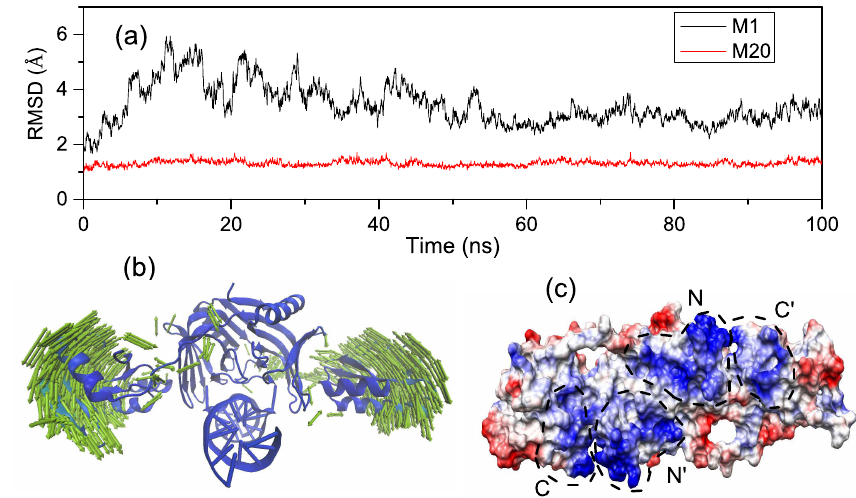
Figure 5. ( a ) The root mean square deviation (RMSD) of EndoMS/NucS C α atoms of the open state (M1) and the closed state (M20), relative to the starting structure, as a function of time. ( b ) Principal component analysis of M1. ( c ) Electrostatic surface representation of EndoMS/NucS (scale, − 10 kcal/(mol · e) to +10 kcal/(mol · e), red to